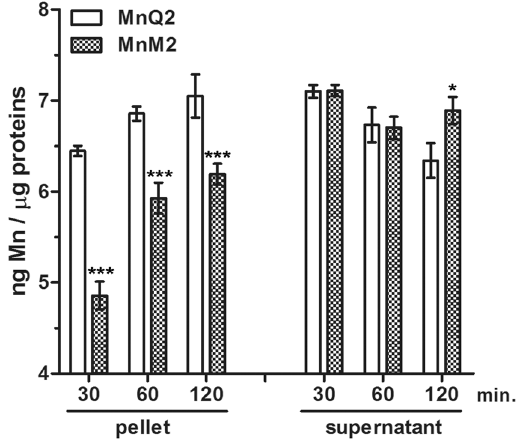
Figure 6. Time-related permeation of MnQ2 and MnM2 into H9c2 cell fractions evaluated as intracellular Mn amounts. The pellet fraction contains mitochondria whereas the supernatant fraction corresponds to cytosol. Upon incubation with MnQ2 (10 μ mol L − 1 ), Mn rises steadily in both cell fractions since 30 min. Upon incubation with MnM2 (10 μ mol L − 1 ), Mn also rises steadily in the cytosolic fraction but shows a time-related increase in the mitochondrial fraction. In this fraction, Mn was significantly higher with MnQ2 than with MnM2 at every time point. *** p < 0.001, * p < 0.05 (two-way